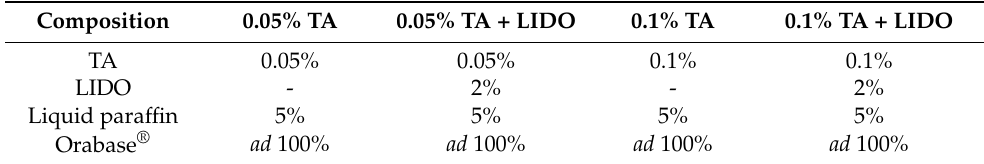
Table 1. Composition of the four different